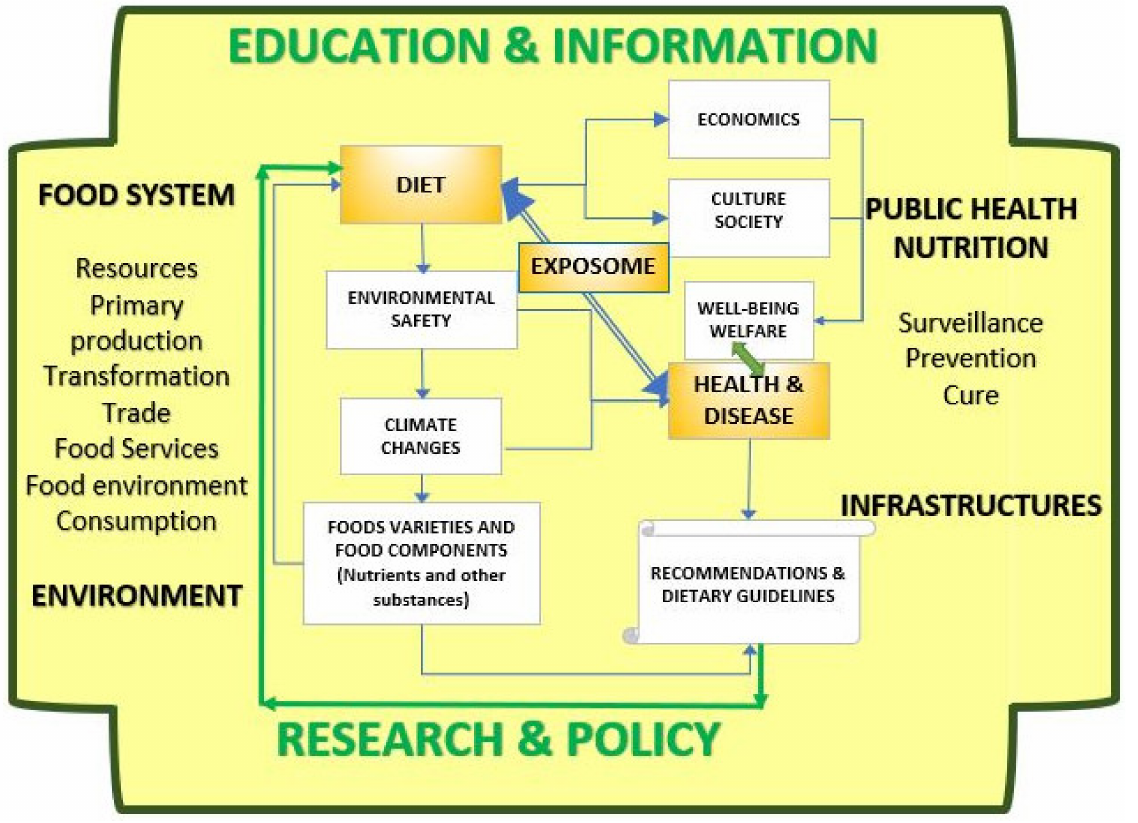
Figure 1. Diet health and disease: a visual map connecting components. Source: own design. Note: each rectangle represents a concept the lines indicate direct links and the arrows indicate the direction. Diet-health and disease relationships are regulated by the exposome, condensing determinants coming from the diverse components, and are immersed in a wider system whose major components are food system and public health nutrition formulating policies, supporting research, planning education, and information